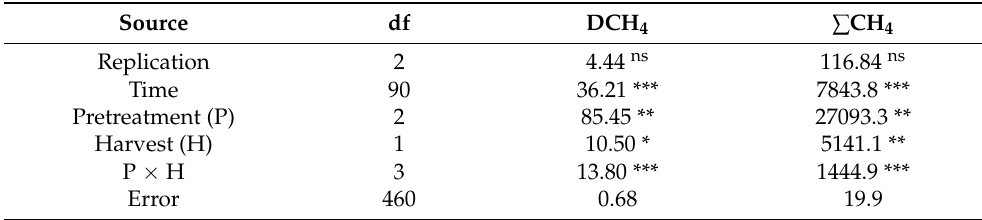
Table 3. Repeated measure ANOVA on daily and cumulated biomethane (DCH4 and ∑ CH4, re- spectively) of untreated and fungal pretreated giant reed in winter and autumn harvest after 30-day incubation. Degree of freedom (df) and adjusted mean square significance: p ≤ 0.001 (***), p ≤ 0.01 (**), p ≤ 0.05 (*), Not significant ( ns ).